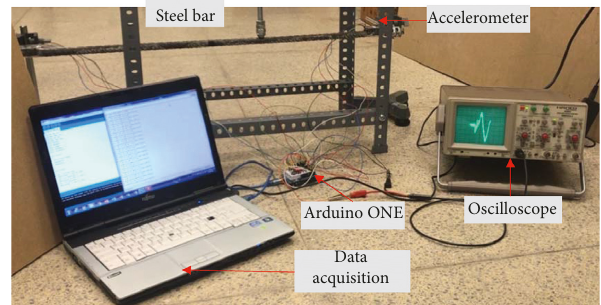
Figure 5: Data collection equipment.